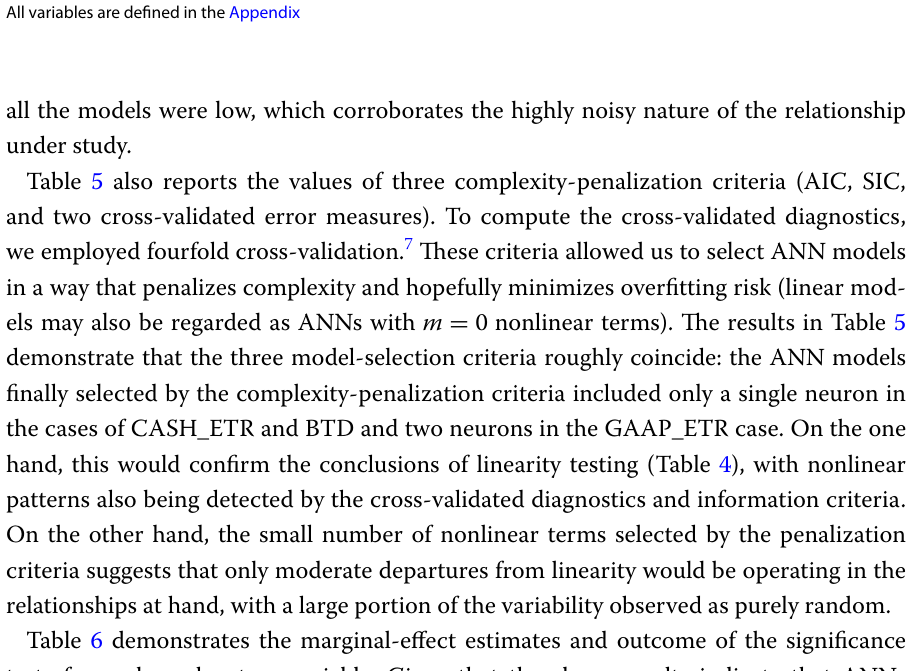
All variables are defined in the